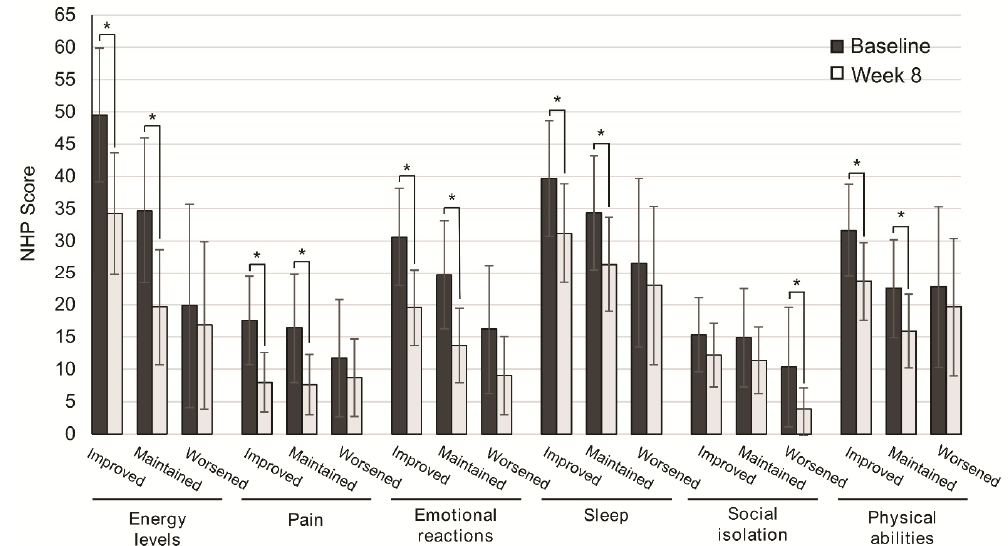
Figure 2. Change in quality of life after 8 weeks of oligomeric enteral nutrition (OEN) by nutritional status evolution. The bars show mean scores ± 95% CI for each category of the Nottingham Health Profile at baseline and after 8 weeks of OEN treatment for patients who improved, maintained, or worsened their nutritional status with the OEN protocol. * indicates p < 0.05 (from baseline to Week 8). The NHP score ranges from 0 (does not perceive any health problem) to 100 (maximum health problems perceived by the